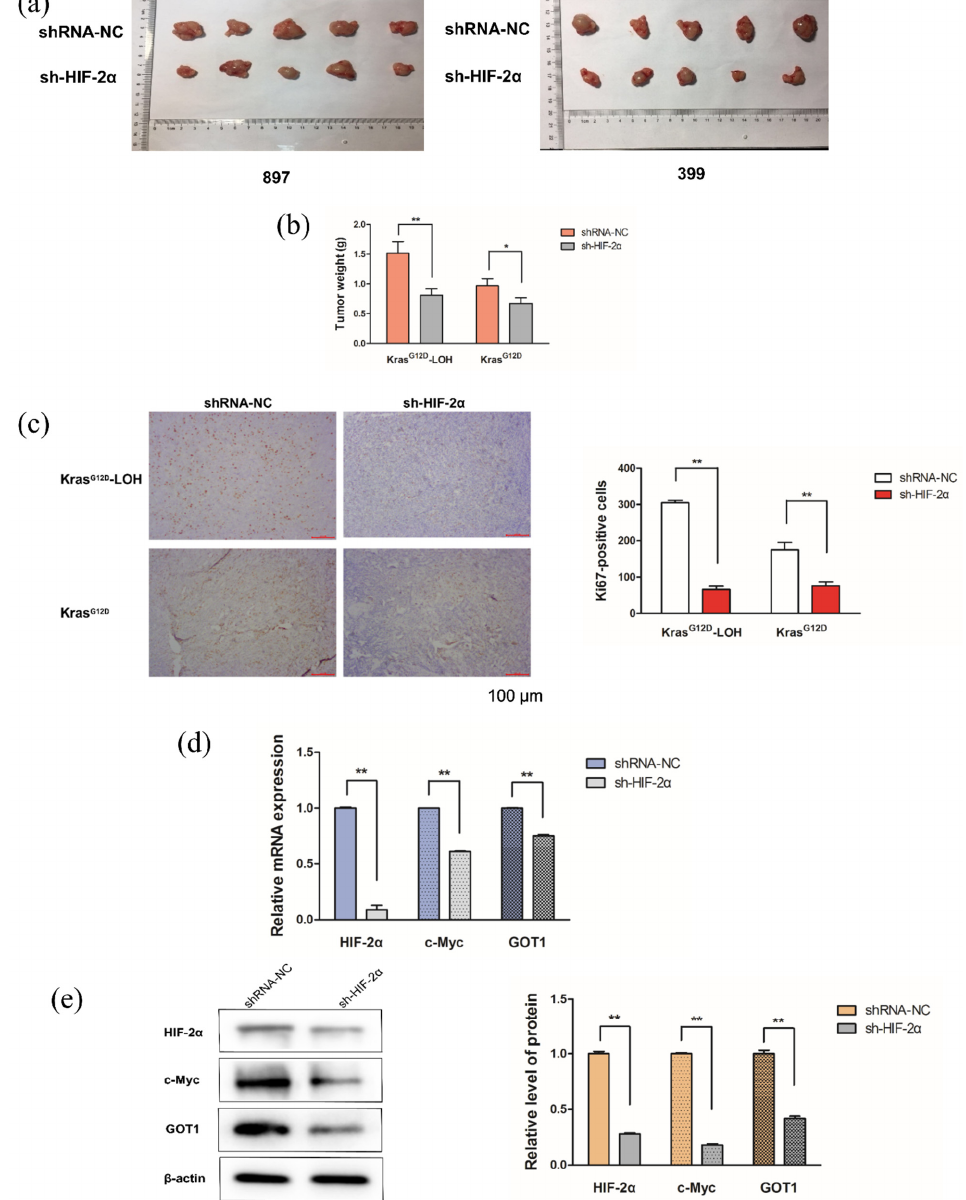
Figure 7. HIF-2 α knockdown represses the malignant phenotype of PDAC cells in vivo and regulates the nonclassical glutamine metabolism. ( a ) Comparison between tumors removed from Kras G12D -LOH and Kras G12D mice. ( b ) Weight of tumors removed from the Kras G12D -LOH and Kras G12D mice. ( c ) Ki67 immunostaining of tumors. ( d ) Relative mRNA expression of c-Myc and GOT1 in Kras G12D -LOH tumor tissues. ( e ) Relative protein expression of c-Myc and GOT1 in the Kras G12D -LOH